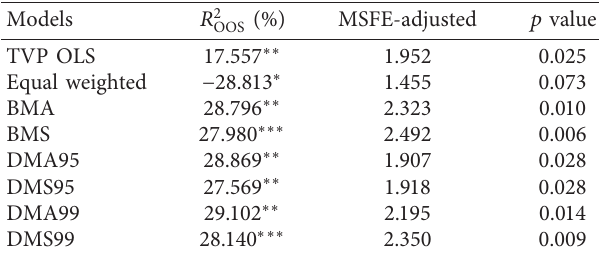
Table 5: Results of Direction-of-Change test. Table 6: Results of out-of-sample R -square